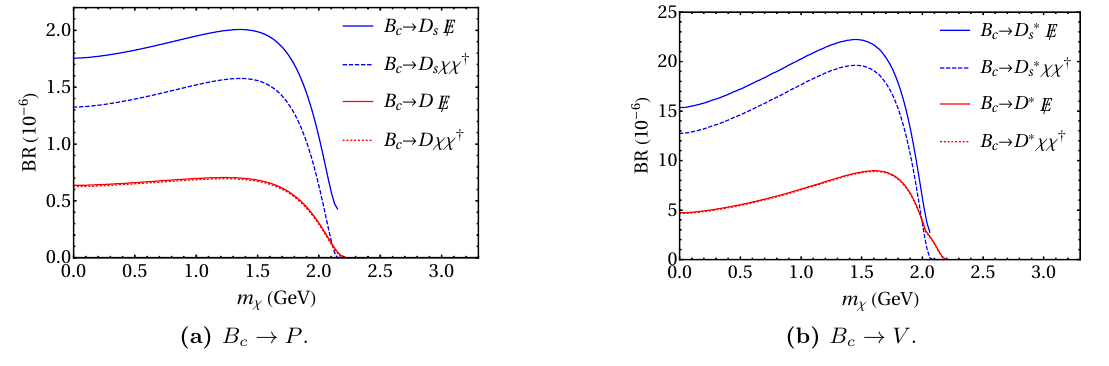
y c ! P ( V ) (cid:31)(cid:31)